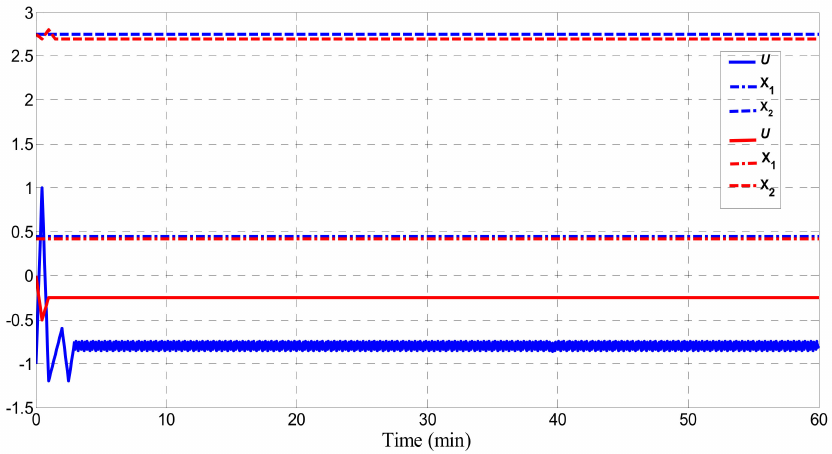
Figure 7. Sliding mode control (SMC) and I/O FBL for D 2 = 0.02, ρ = 1, ϑ = 0.5 (blue) and D 2 = 0.01, ρ = 2, ϑ = 0.55,